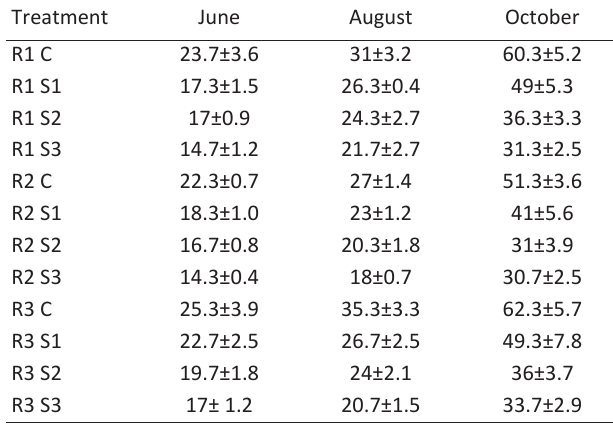
Table 7 - Effect of treatments on average number of ‘Superior Seedless’ leaves grafted on the three rootstocks count- ed in June, August